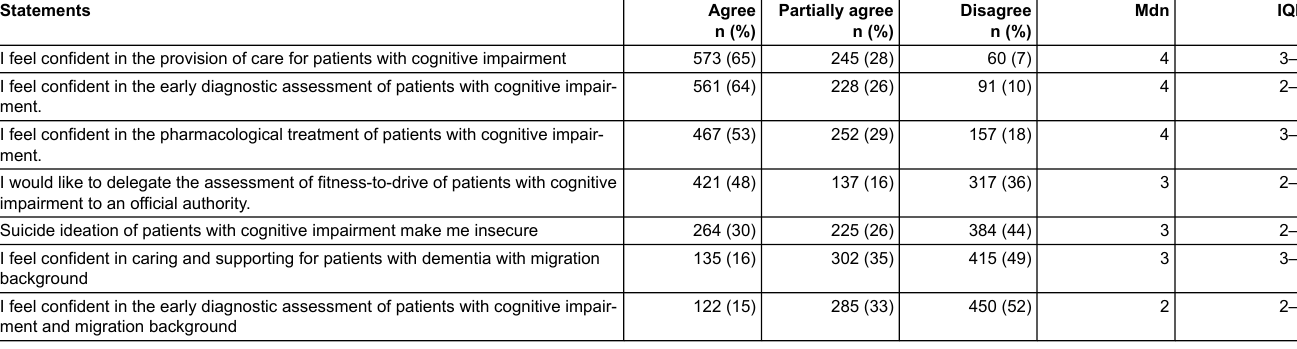
Table S2: Agreement with statements about confidence in different situations of managing patients with dementia.